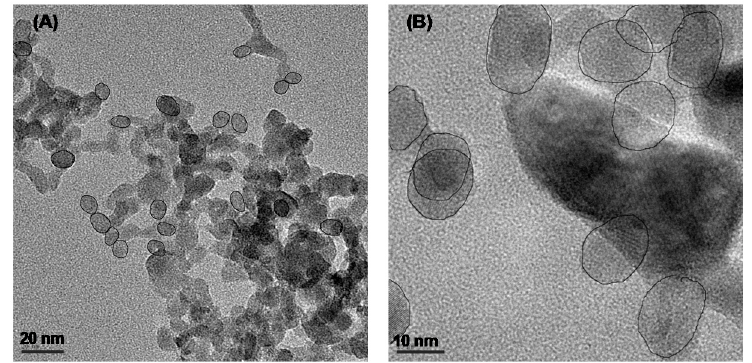
Figure 18. ( A ) Transmission electron microscopy (TEM) images of SrF 2 :Eu10 and ( B ) SrF 2 :Eu10@3 × SrF 2 (selected particles are surrounded by black lines). Reproduced from Reference [59] with the permission of the Royal Chemical Society.